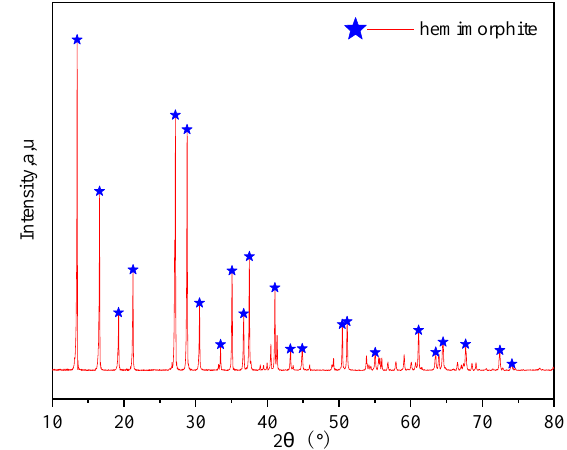
Figure 1. XRD pattern of pure hemimorphite samples.